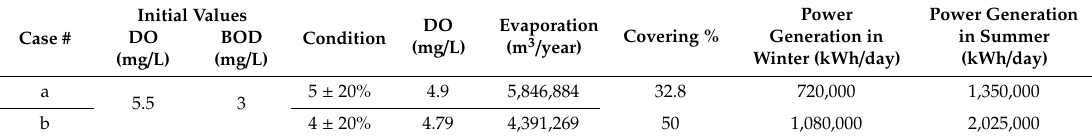
Table 5. Percentage covering results of the DO optimization.